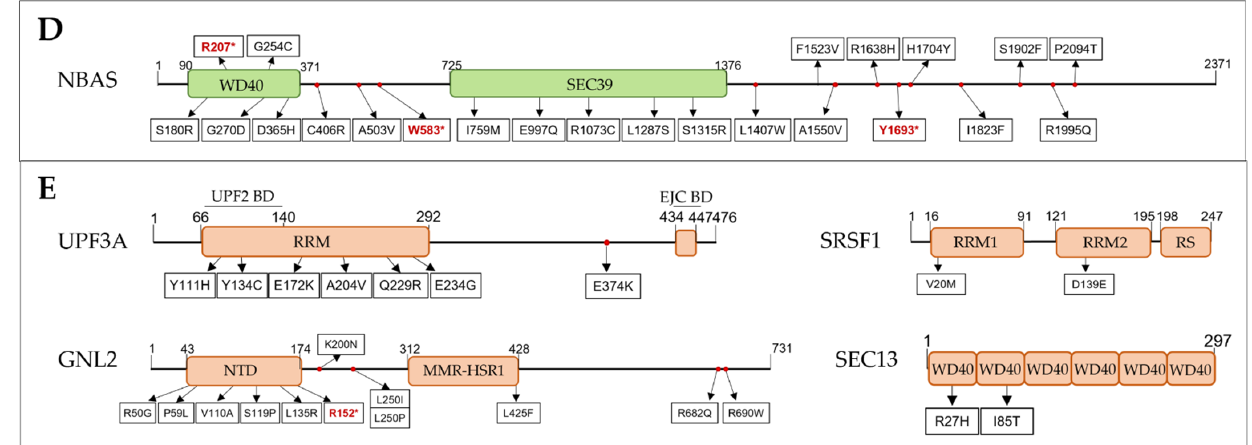
Figure 4. Schematic domain architecture of proteins involved in NMD, and representations of the protein alterations encoded by MISPD and nonsense/frameshift variants identified in ASD subjects. The binding regions for interacting proteins are indicated. Proteins were grouped by NMD groups: ( A ) EJC, ( B ) SURF-DECID, ( C ) mRNA decay, ( D ) ER-NMD and ( E ) Regulator. Legend: MISPD, missense variants predicted to be damaging and deleterious; BD, Binding Domain; CH, cysteine and histidine-rich domain; SQ, serine- and glutamine-rich domain; RS, arginine and serine-rich domain; RRM, RNA recognition motif; EJC, Exon Junction Complex; PIN, PilT N-terminus; P-UPF1, phosphorylated UPF1; WH, Winged-Helix; CTD, C-terminal domain; NTD, N-terminal domain.